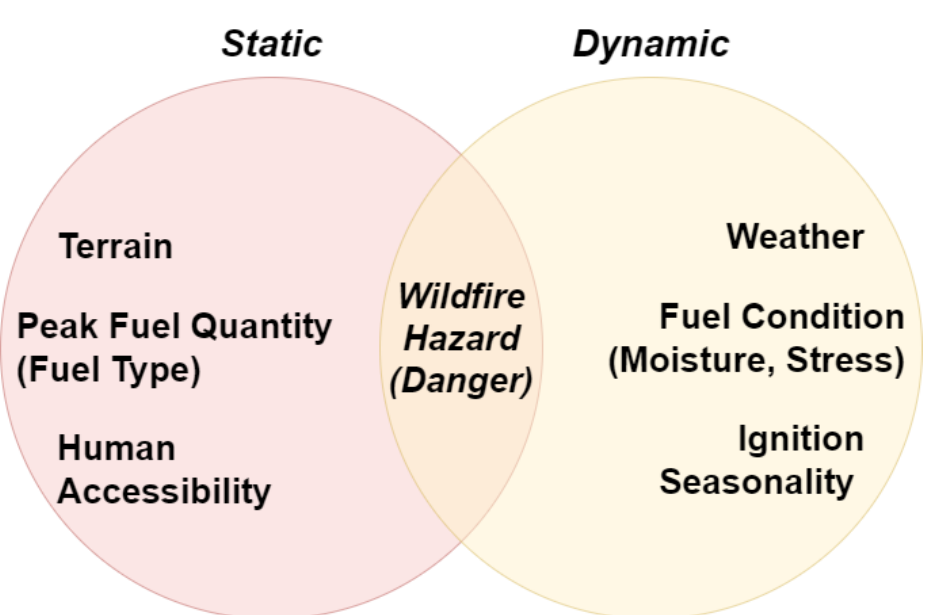
Figure 1. Conceptual scheme of the dual component of wildfire hazard or danger: the static factors and the dynamic